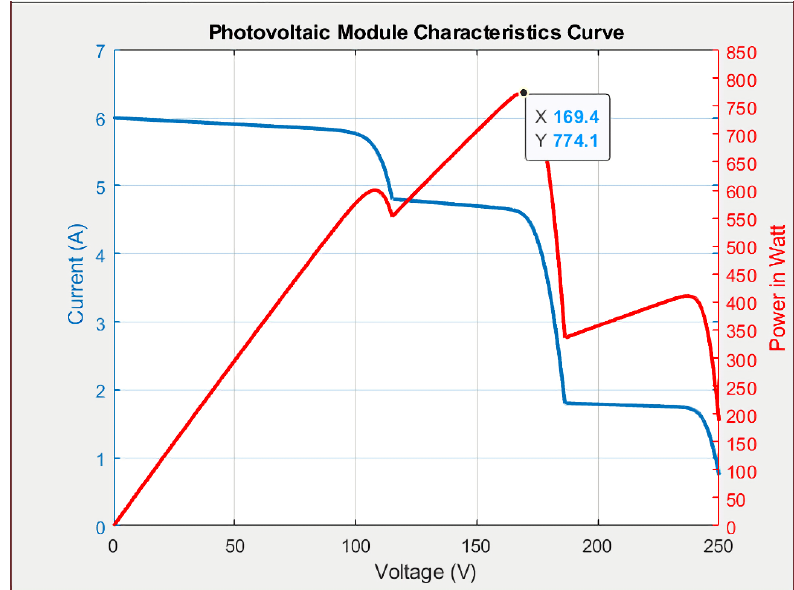
Figure 9. Simulated P – V and I – V characteristic curve for Case 3.